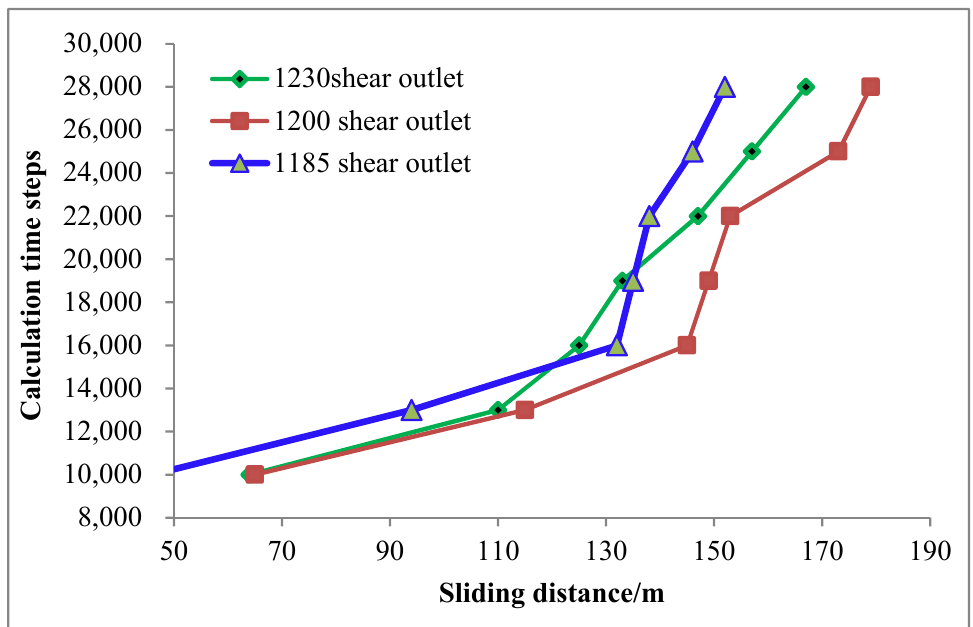
Figure 14. Influence range of different sliding surface positions.